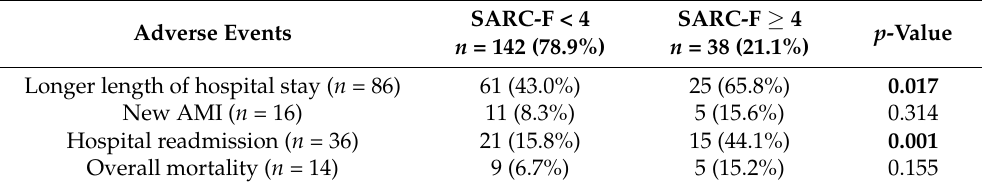
Table 2. Risk of sarcopenia and short- and long-term adverse events in patients after an acute cardiovascular event ( n =